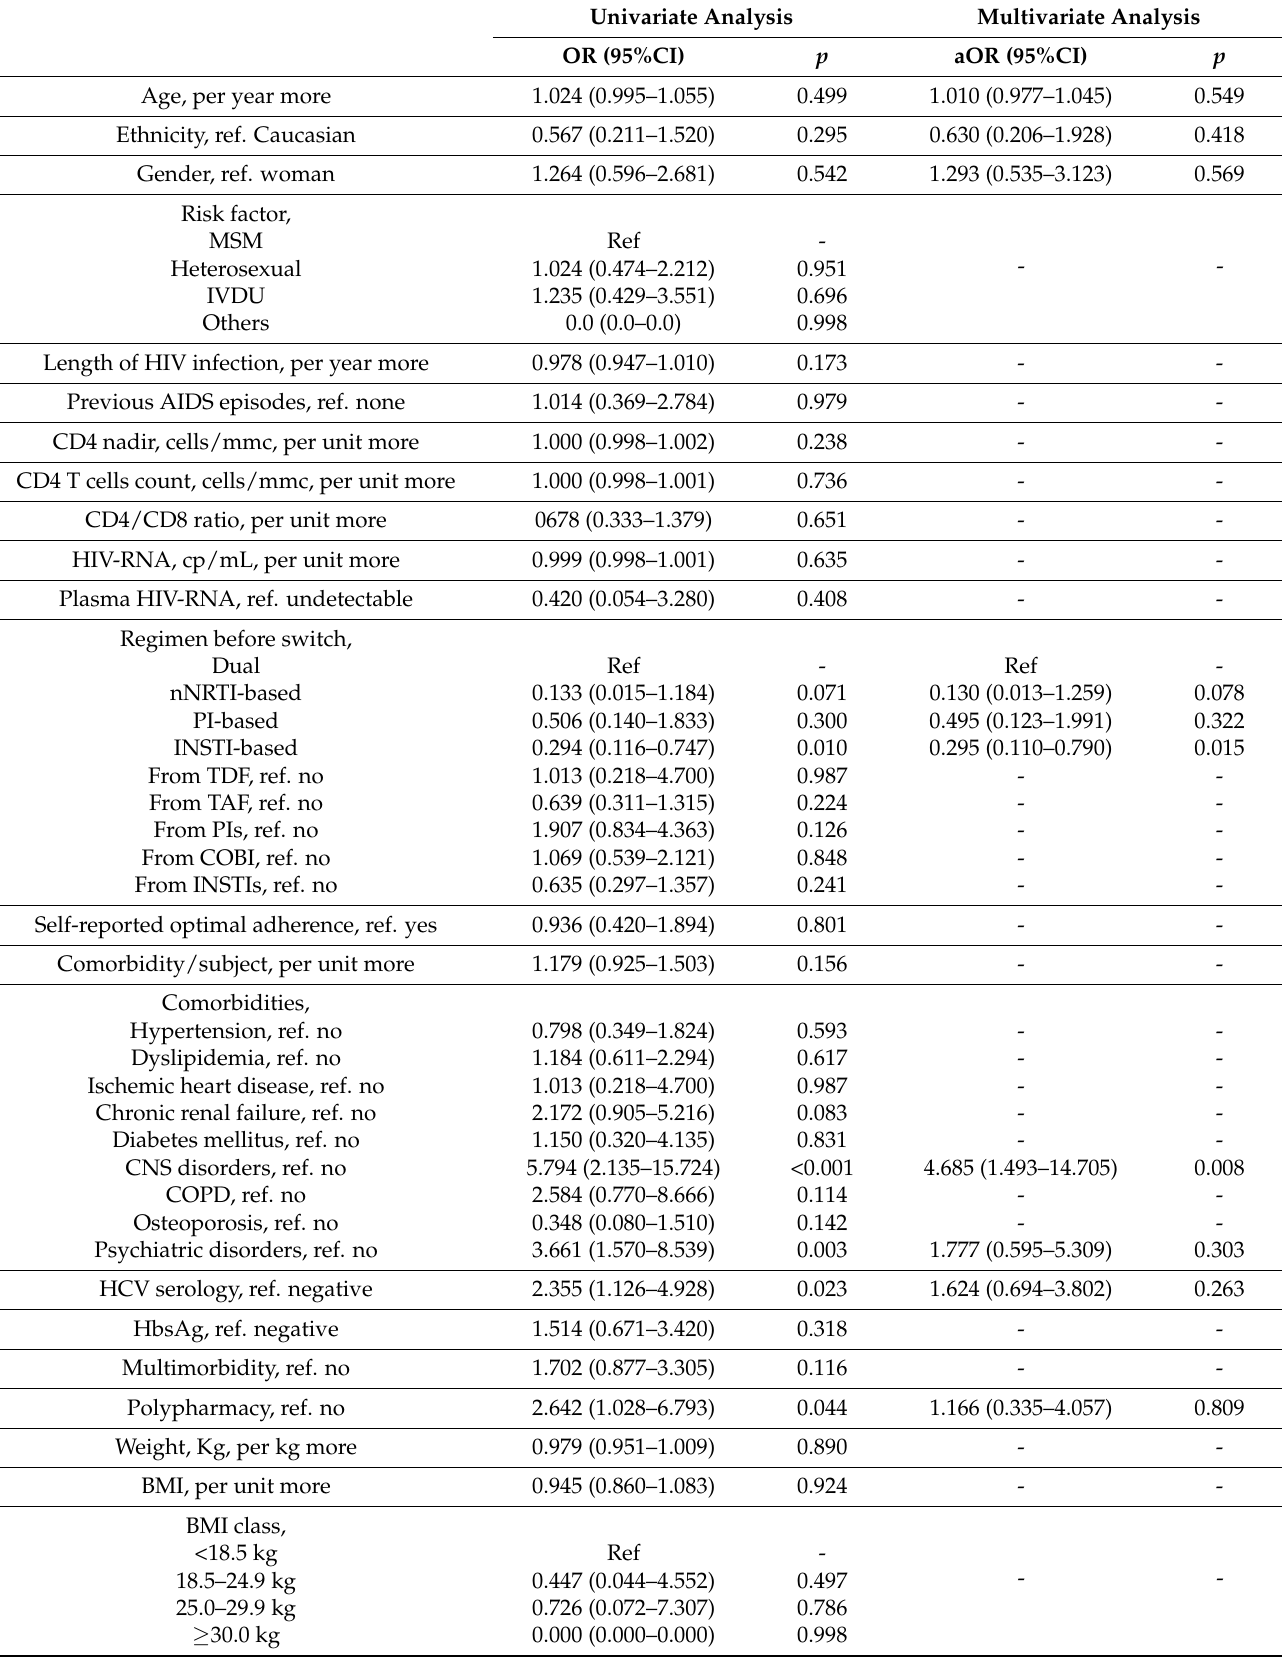
Table 3. Univariate and Multivariate analysis for BIC/FTC/TAF discontinuation. Univariate